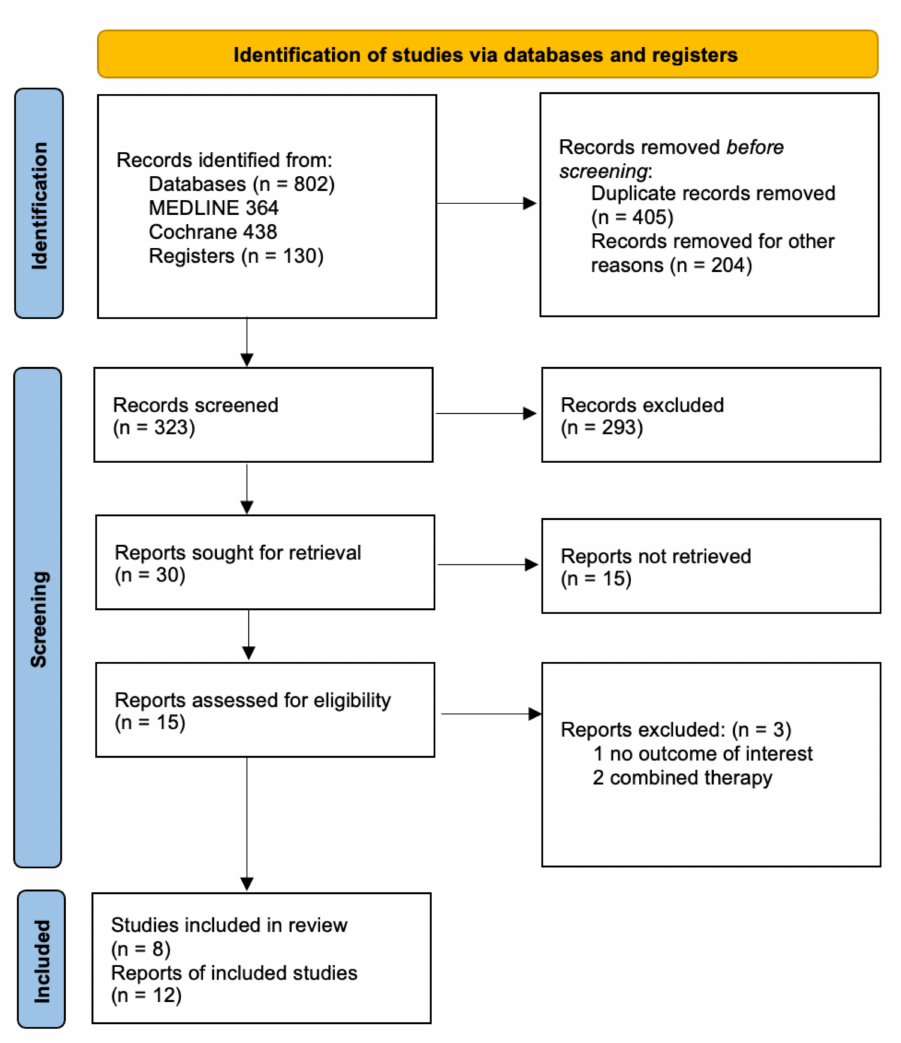
Figure 1. PRISMA flow